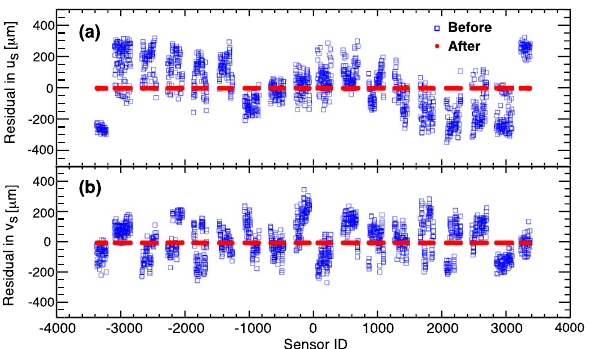
Fig. 11 The residual biases in a the u s and b the v s directions of the individual sensors of the 180 ◦ test-beam runs using the alignment corrections from the nominal runs but before (open squares) and after (full circles) the additional alignment on the external